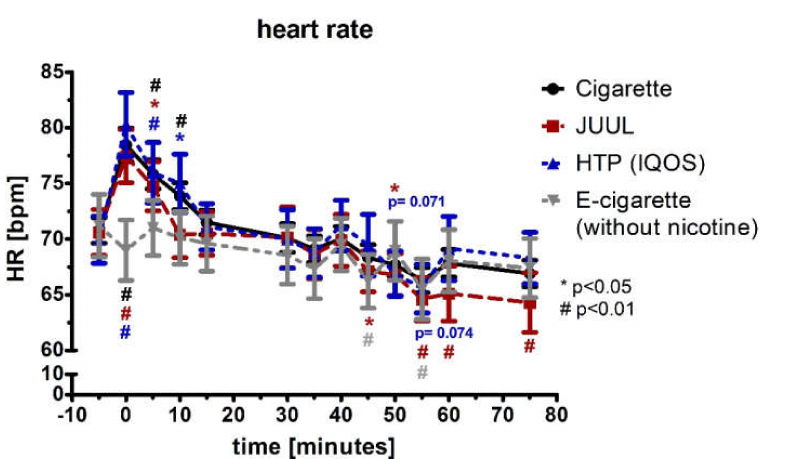
Figure 6. Heart rate in a frequency of 5 min until 75 min after consuming the cigarette, JUUL TM , heated tobacco product, and e-cigarette without nicotine. There was a significant increase in the heart rate right after the consumption of the cigarette, JUUL™, and heated tobacco product.